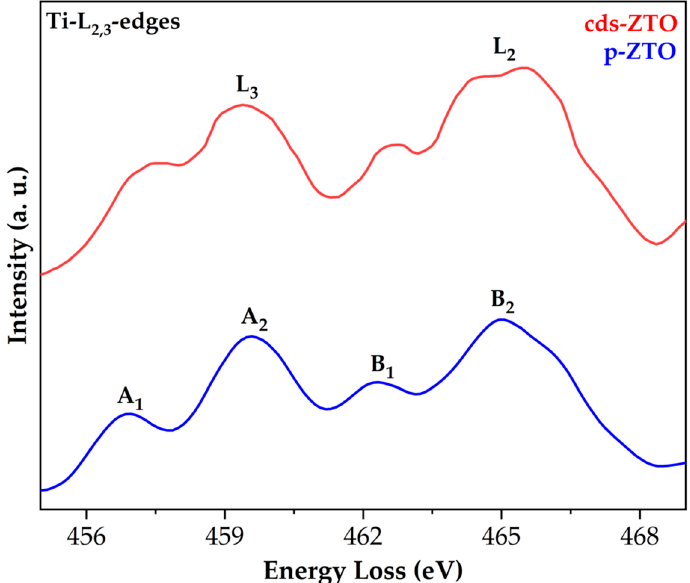
Figure 5. Ti-L 2 , 3 -edges for the electron energy loss spectra (EELS) of cds-ZTO and p-ZTO samples.